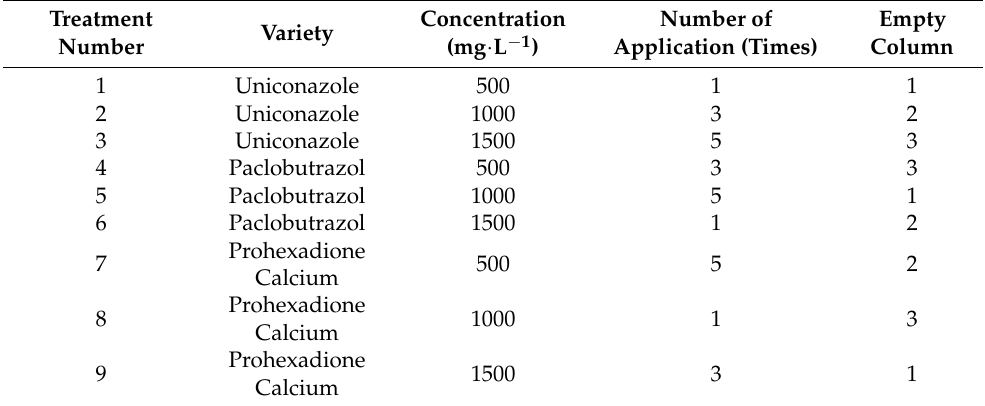
Table 1. L9 (3 4 ) orthogonal experimental